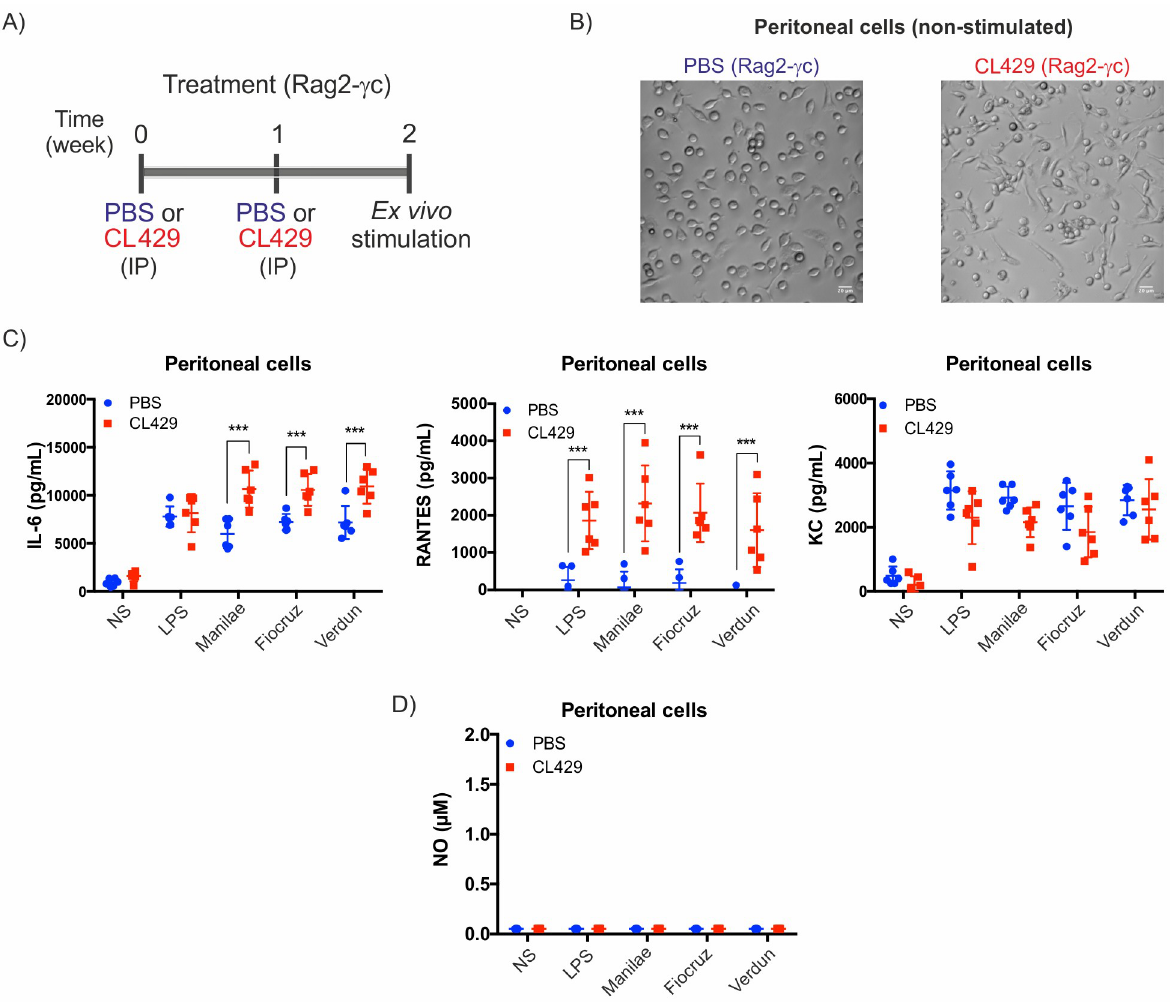
Fig 4. Myeloid cells are responsible for CL429-induced protection in the peritoneal cavity. A) Chronogram of the experiment. Rag-2 γ c mice were injected IP with 200 μ L PBS containing 2.5% DMSO (vehicle) or 25 μ g CL429 2 and 1 weeks before the collection of peritoneal cells for ex vivo stimulation. Cells were plated and exposed for 24 h to E . coli LPS (100 ng/mL) or Leptospira interrogans serovar Manilae, Fiocruz or Verdun, at MOI of 100. B) Representative phase contrast microscopy image of non stimulated peritoneal cells seeded in 96-well plates at 3 h post-collection. C) Pro- inflammatory cytokine (IL-6) and chemokine (RANTES and KC) production determined by ELISA in the supernatant of cells 24 h post-stimulation. Data are representative of 2 independent experiments (n = 6 mice per group, treated individually). Statistical analysis was performed by the unpaired t -test comparing PBS vs CL429. D) Nitric oxide (NO) production in peritoneal cells at 24 h after stimulation assessed by the Griess reaction. Data are representative of 2 independent experiments (n = 6 mice per group, treated individually). Statistical analysis was performed by 2-way ANOVA comparing PBS vs CL429 for each secondary stimulation. � p -value < 0.05; �� p -value < 0.01; ��� p -value < 0.001.